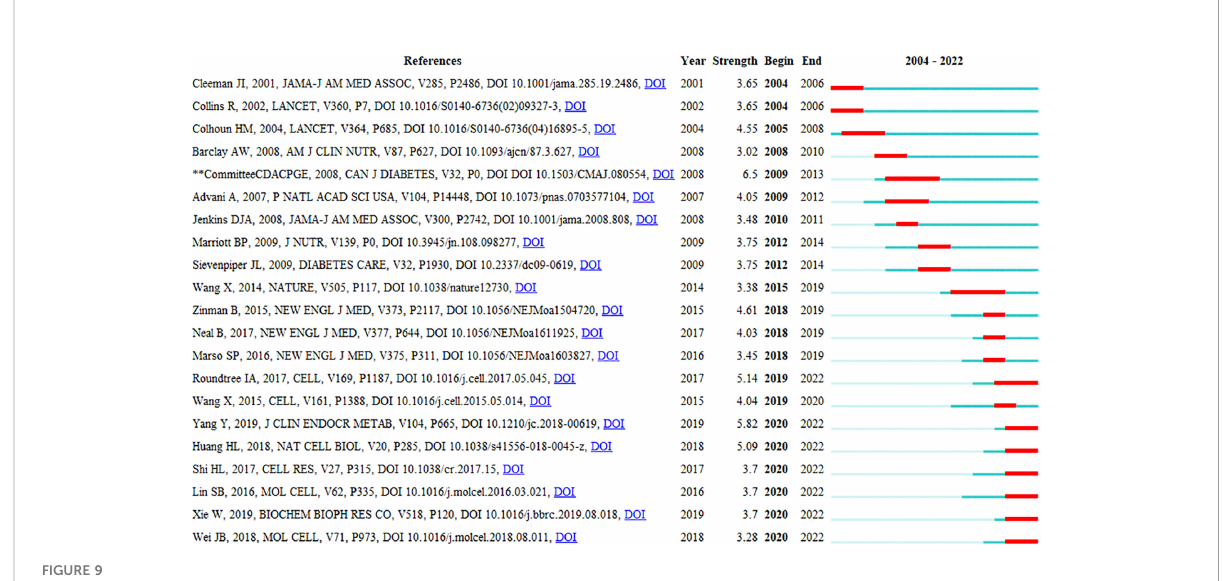
FIGURE 9 Top 21 references with the strongest citation bursts related to RNA methylation in DM and its complications.